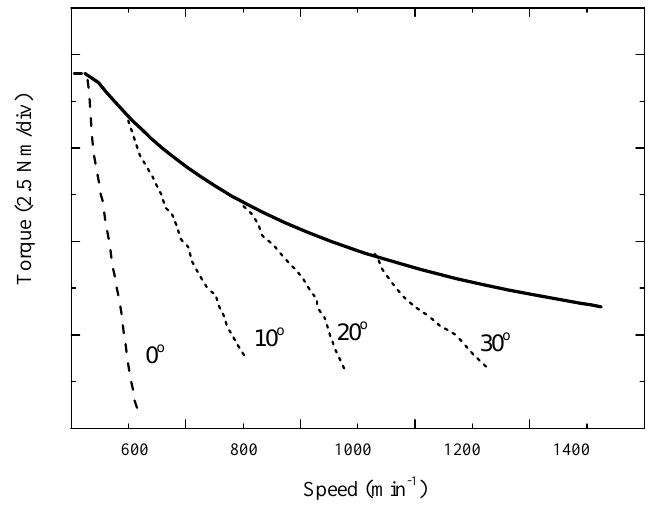
Figure 19. Output torque versus motor speed for different advanced